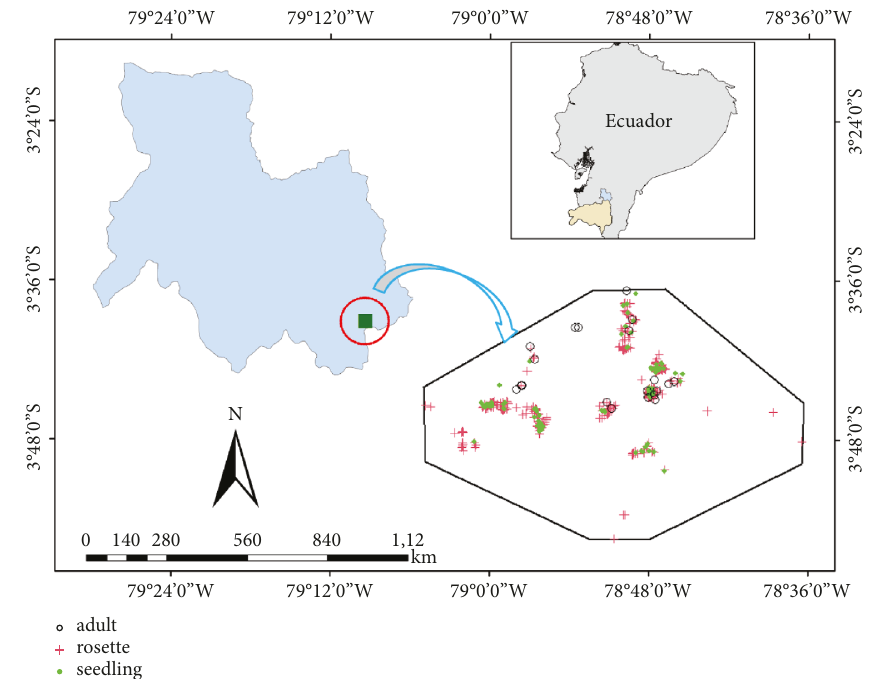
Figure 1: Site of study (Aguarnudas montane forest,